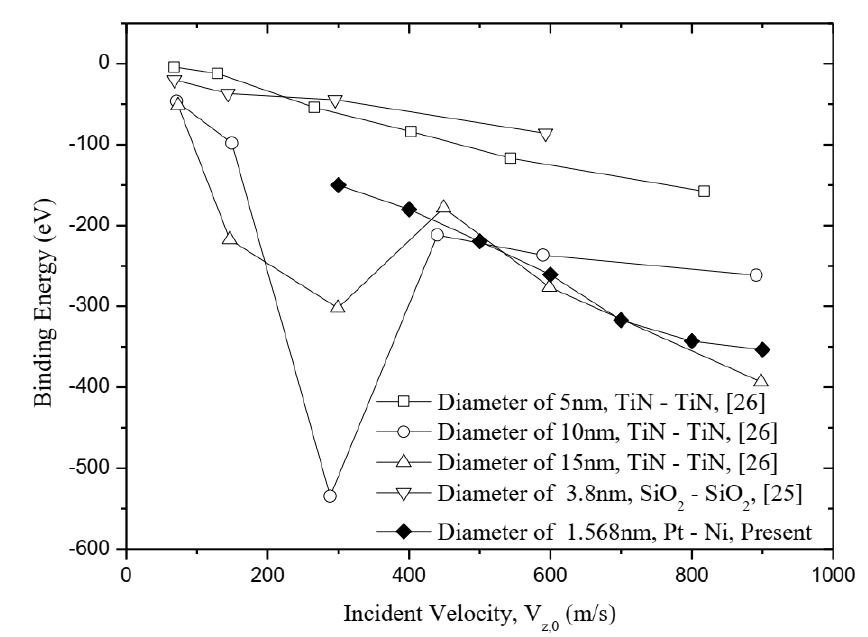
Figure 2. Comparison of binding energy between the present results and those of the literature